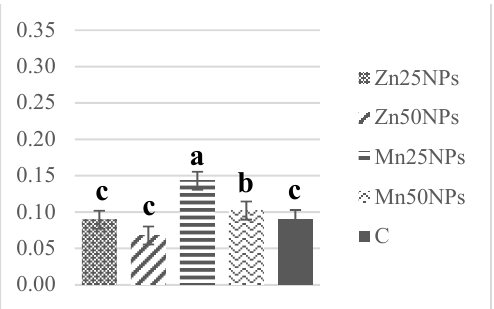
Figure 10. SOD activity (U/mg) in samples of turkey sperm stored for 2 h with or without (C) the addition of ZnNPs and MnNPs. * Different letters (a, b, c) indicate statistically significant differences at p ≤ 0.05. The bars with various letters are significantly different from one another.